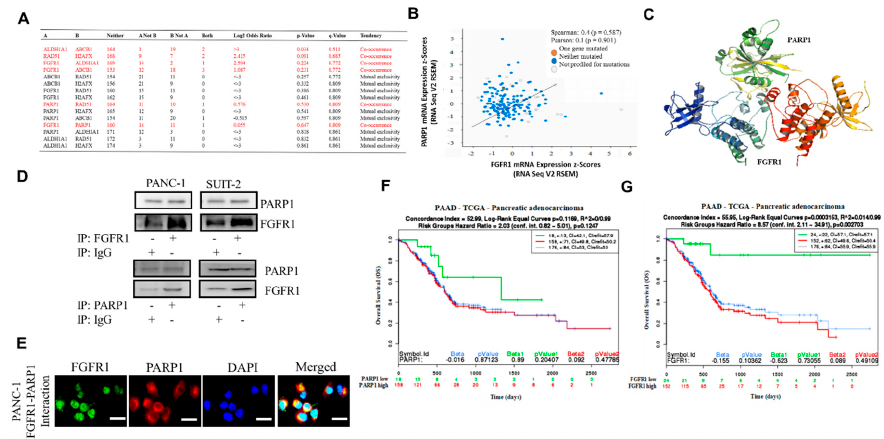
adenocarcinoma cohort. ( B ) FGFR1-PARP1 gene expression correlation in the TCGA pancreatic adenocarcinoma cohort. ( C ) Schrödinger’s PyMOL molecular graphics system-generated molecular (IP) with FGFR1 (upper) or PARP1 (lower) antibody followed by Western blotting analysis with the indicated antibodies, with IgG serving as the control. ( E ) Interaction of PARP1 with fibroblast growth factor receptor 1 (FGFR1). Coimmunolocalization assays of PARP1 and FGFR1 in the PANC1 cancer cell lines expressing wild-type PARP1 and FGFR1. Kaplan–Meier plots showing the di ff erential overall survival (OS) between ( F ) FGFR1-low and FGFR1-high samples or ( G ) PARP1-low and PARP1-high samples from the TCGA pancreatic adenocarcinoma